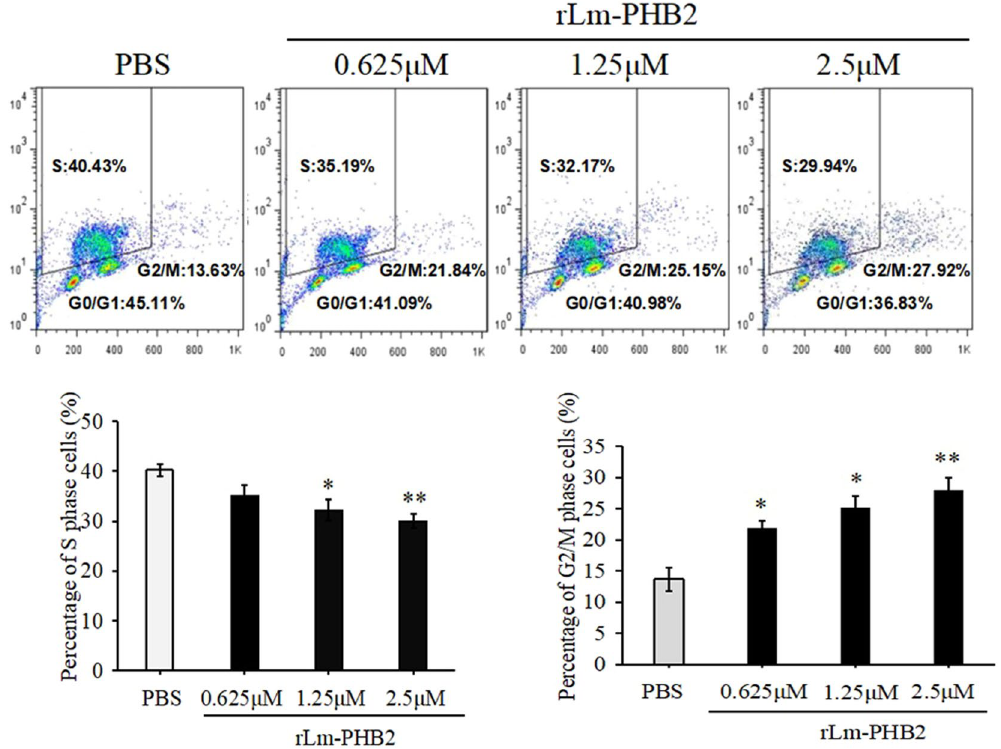
Figure 3. Effect of Lm-PHB2 on the cell cycle. The double staining with both APC-BrdU and PI for detection of G1/S and/or G2/M cell cycle alteration after HeLa cells treated with rLm-PHB2 protein and PBS treatment as